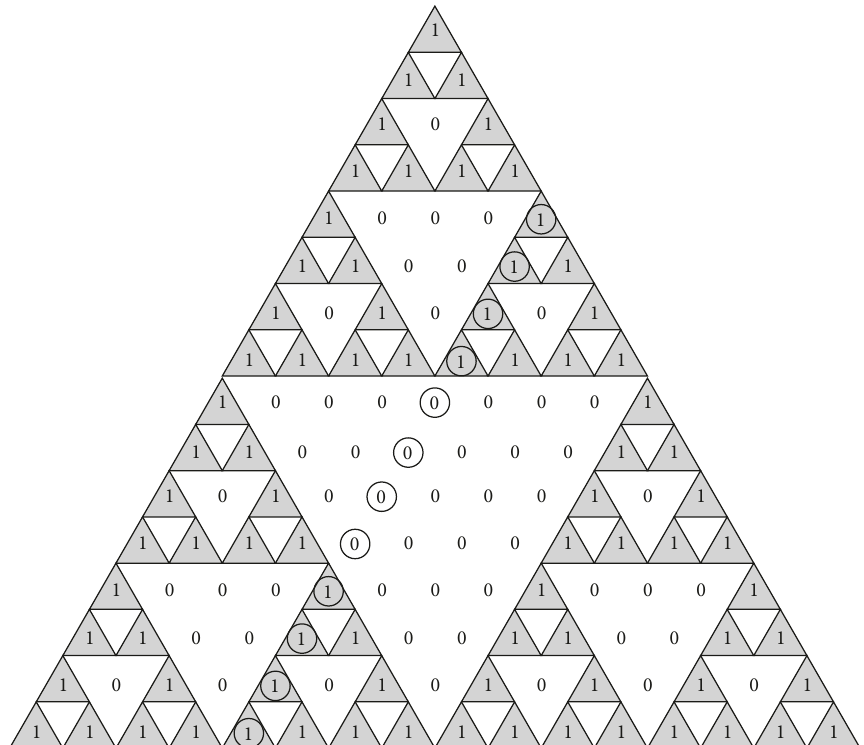
Figure 4: Binary Sierpinski’s triangle where the circled bits correspond to the sequence {( 𝑛 4 )}